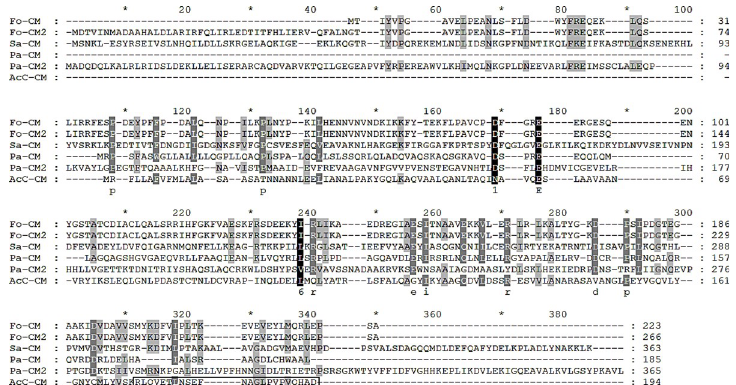
Fig 3. Alignment of the chorismate mutase amino acid sequences from different organisms. Aligned amino acid sequences of F . oxysprum chorismate mutase (EWY95915), F . oxysprum chorismate mutase 2 (EWY95914), S . aureus chorismate mutase (OHS92057), P . aeruginosa chorismate mutase (OHQ59631), P . aeruginosa chorismate mutase 2 (KJJ16793), and A . castellanii Castellani chorismate mutase (MN630520) were compared. The boxed sequence corresponds to the antigen peptides used to raise the anti-chorismate mutase polyclonal antibody. Fo; Fusarium oxysporum , Sa; Staphylococcus aureus , Pa; Pseudomonas aeruginosa